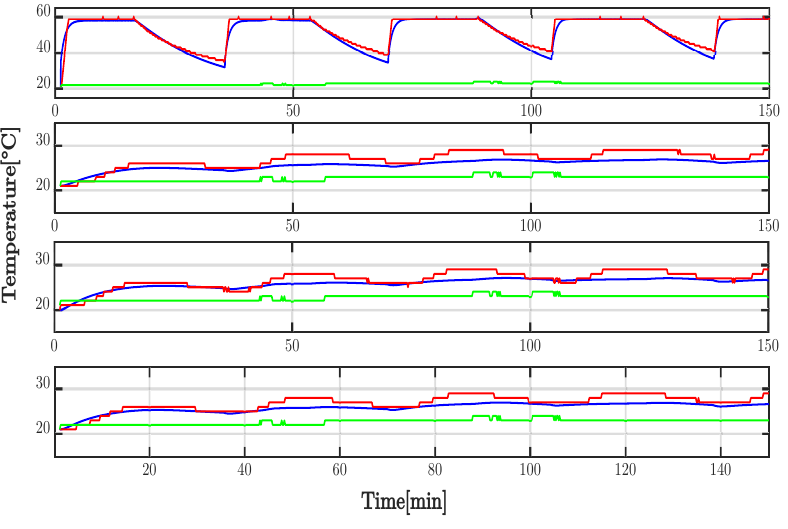
Figure 15. Experimental and simulated results for four thermal zones. The mathematical model was tuned for the charging and discharging process. Table 2 shows the coefficients for the charging phase, explaining the coefficients used in each case. Similarly, Table 3 shows the heat transfer coefficients for the discharge